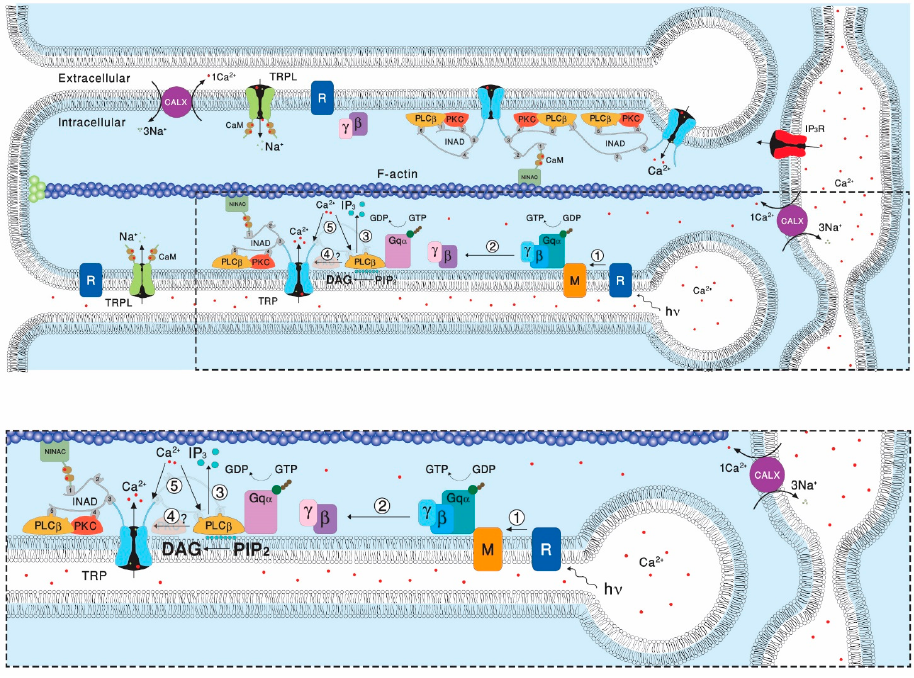
Figure 1. The phosphoinositide cascade of vision. A diagram showing the molecular components of the signal transduction cascade of Drosophila : 1. Upon absorption of a photon (h ν ), rhodopsin (R) is converted into metarhodopsin (M). 2 . The R to M photoconversion leads to the activation of heterotrimeric G protein (Gq αβγ ) by promoting the GDP to GTP exchange. 3 . The GTP-bound Gq α , in turn leads to activation of phospholipase C β (PLC β ), which hydrolyzes PIP 2 into the soluble IP 3 and the membrane bound DAG. 4 . PLC β in a still unclear way activates the TRP and TRPL channel, leading to an increase in microvillar Ca 2+ concentration. 5 . The increased Ca 2+ concentration feeds back and negatively regulate both PLC and TRP channels activities. Elevation of DAG and Ca 2+ promotes eye-specific protein kinase C (PKC) activity, which regulates channel activity. PLC β , PKC, and the TRP ion channel form a supramolecular complex with the scaffolding protein INAD, which is bound to the F-actin cytoskeleton via the NINAC protein. Ca 2+ level in the microvilli is also regulated by the Na + -Ca 2+ exchanger, CALX. The diagram at the bottom is an amplification of the box marked by dotted lines in the upper diagram. (Modified from [14]).